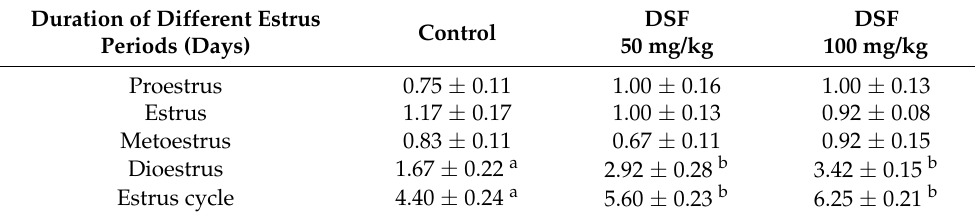
Table 1. Effects of different concentrations of DSF on the estrous cycle in mice.